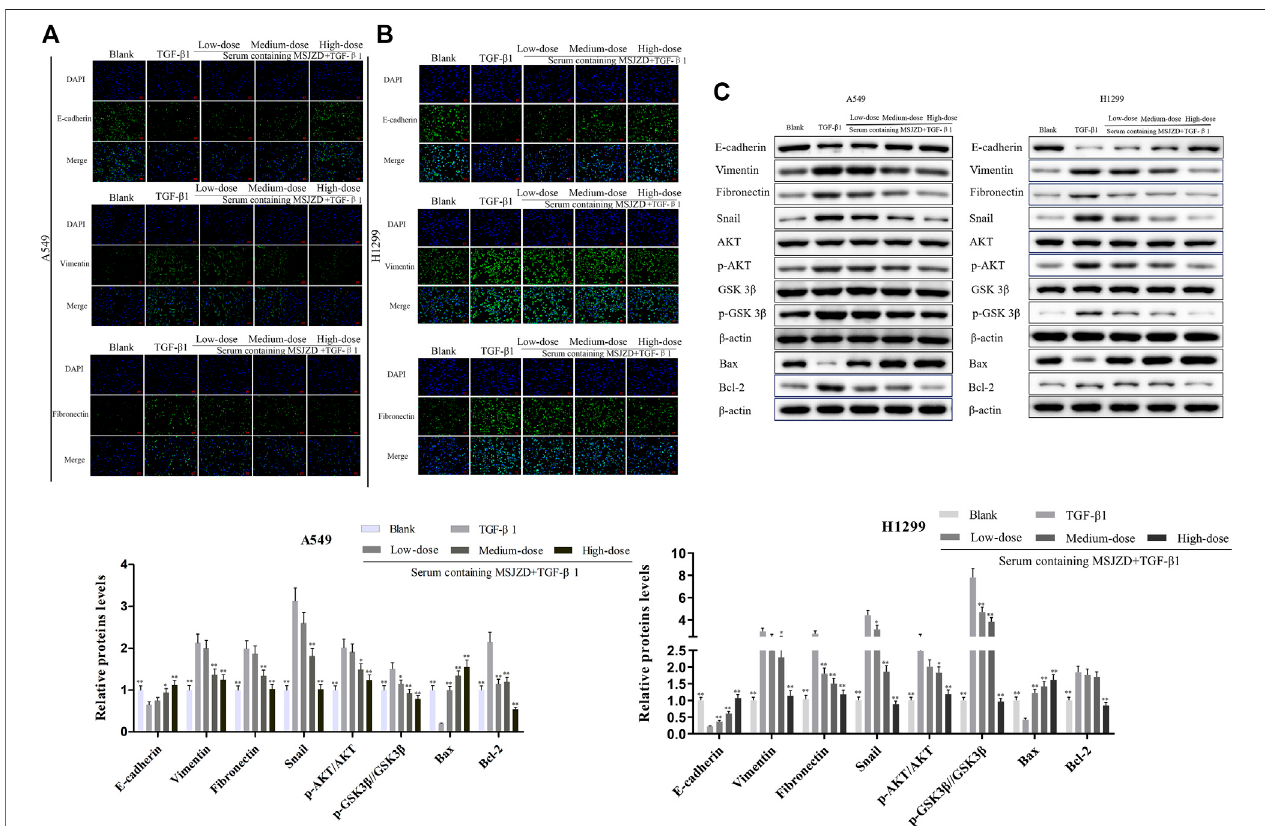
FIGURE 6 | Serum-containing MSJZD weakened EMT, AKT/GSK3 β pathway and induced apoptosis-related markers in NSCLC cells triggered by TGF- β 1. The EMTprotein levels ofA549 (A) and H1299 (B) weredetected byimmuno fl uorescence. (C) Thelevels ofE-cadherin, Vimentin, Fibronectin,Snail,p-AKT, AKT, p-GSK3 β , GSK3 β , and apoptotic proteinswere detected by western blot after treatment with serum-containing MSJZD in A549and H1299 cells. * p < 0.05, ** p < 0.01. versus the TGF- β 1